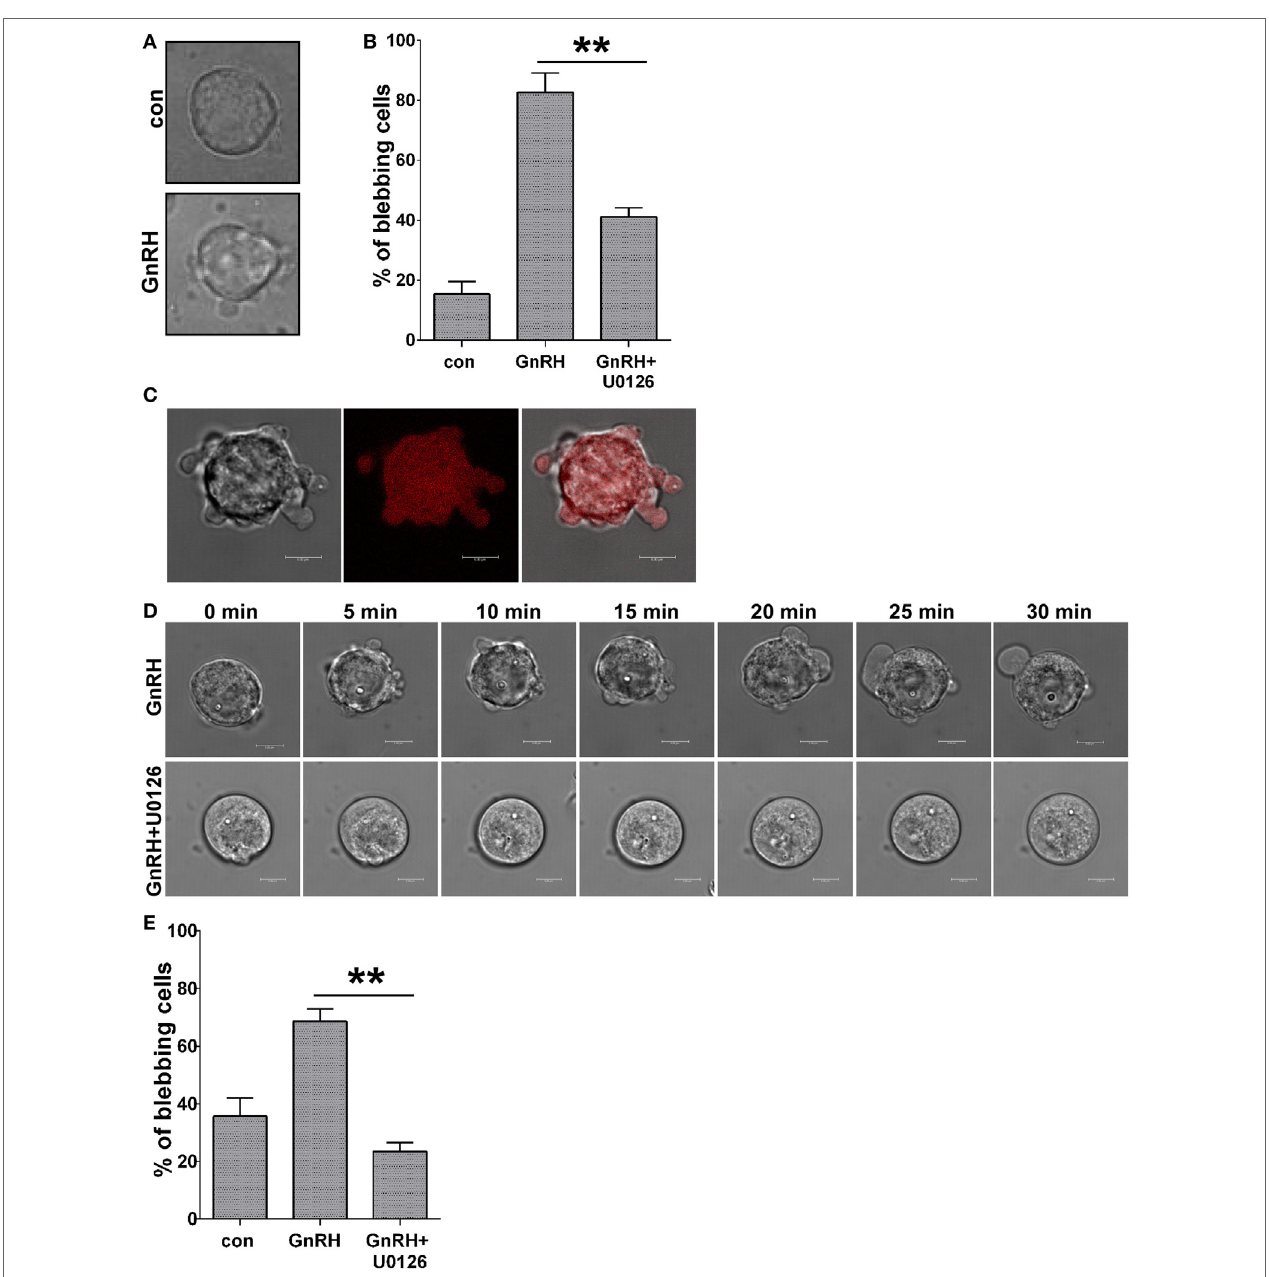
FigUre 8 | gnrh induces erK1/2-dependent bleb formation in primary cultures of rat pituitary cells and isolated mouse gonadotropes . (a) DIC images from a confocal microscope of dissociated rat pituitary cells. Culture rat pituitary cells were prepared, and gonadotropes were identified by their Ca 2 + response as described in Section “Materials and Methods.” The cells were treated with GnRH (10 nM) for 30 min. (B) Quantitation of the percentage of blebbing cells from dissociated rat pituitary cells. The cells were pretreated with U0126 (10 µM) for 30 min, followed by GnRH (10 nM) for additional 30 min. Data are mean ± SEM from three experiments. (c) DIC and fluorescent images from a confocal microscope of FACS-purified primary gonadotrope cells from adult GRIC/Ai9 mice treated with GnRH (30 min, 10 nM). The scale bar is 5 µm. (D) Images from a confocal microscopy time-lapse movie of FACS-purified primary gonadotrope cells. The cells were pretreated with or without U0126 (25 µM) for 30 min, followed by GnRH (10 nM) for additional 30 min. The scale bar is 5 µm. (e) Quantitation of the percentage of blebbing cells from panel (D) is presented (at least 30 cells for each experiment) and data are mean ± SEM. ** p -value ≤